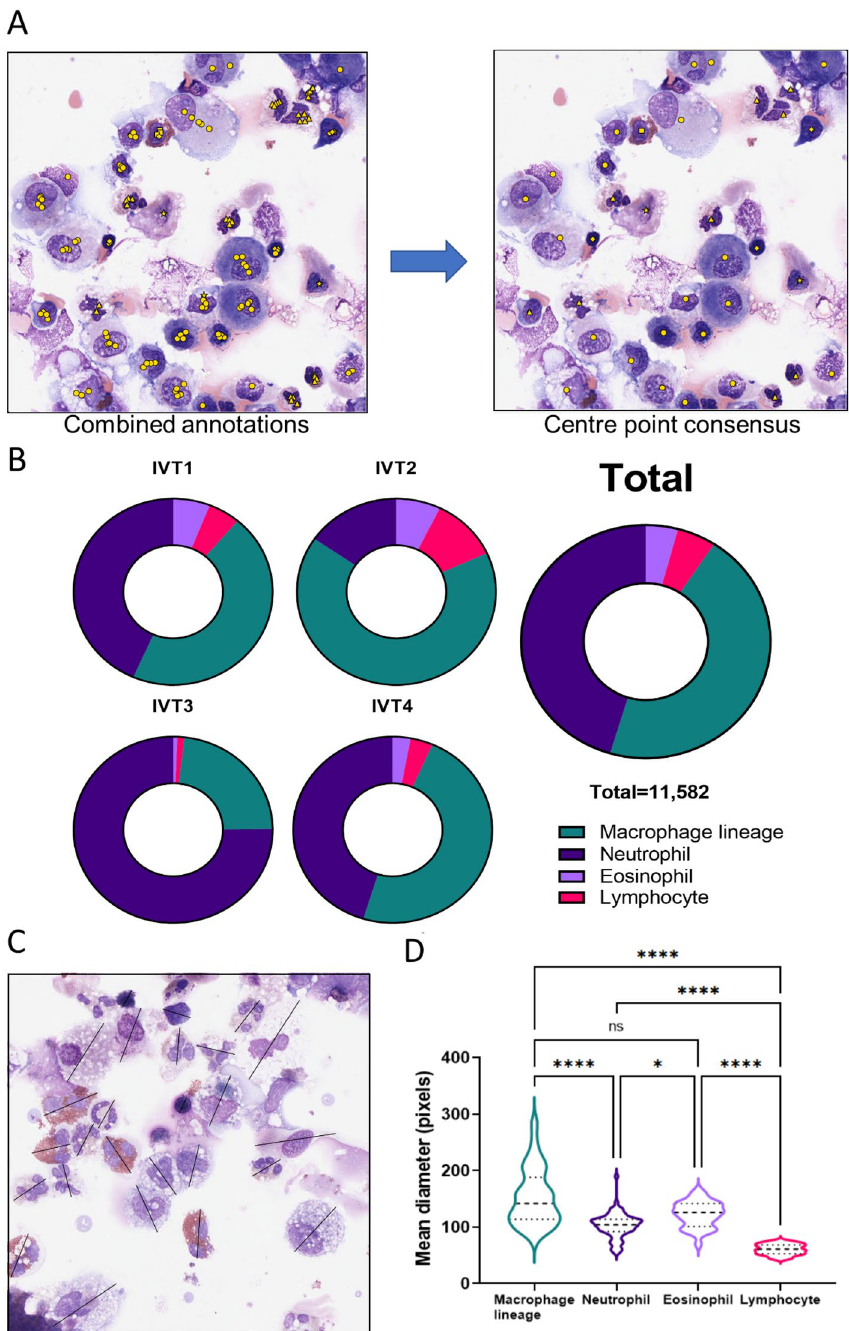
Figure 2. Final image label data used in the study. ( A ) Individual annotations by the four assessors were combined, determined by majority consensus. Symbols are in yellow for clarity, highlghting macrophage lineage (circle), neutrophil (triangle), eosinophil (square) and lymphocyte (diamond). ( B ) Final composition of the consensus annotated cell events. Data is presented for the four separate digital image datasets (each containing at least 160 images) used for interperson variability testing (IVT) and the total dataset of annotated 760 images. IVT1: 3 CF cytospins, 2 asthma; IVT2: 4 CF, 0 asthma; IVT3: 0 CF, 5 asthma; IVT4: 0 CF, 5 asthma. ( C ) Widths of cell objects were measured across the longest distance per object and recorded as number of pixels. ( D ) Immune cell classes were significantly different from each other (Kruskall–Wallis test with Dunn’s multiple comparison